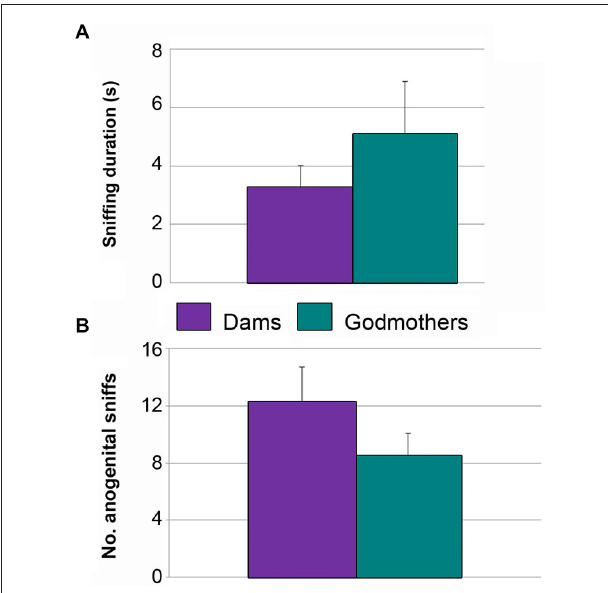
FIGURE 6 | Dams and godmothers did not differ in socio-sexual investigation of a stimulus conspecific in a neutral arena. (A) Time (mean ± SEM) that dams and godmothers spent sniffing the intruder. (B) Number of anogenital approaches of dams and godmothers to